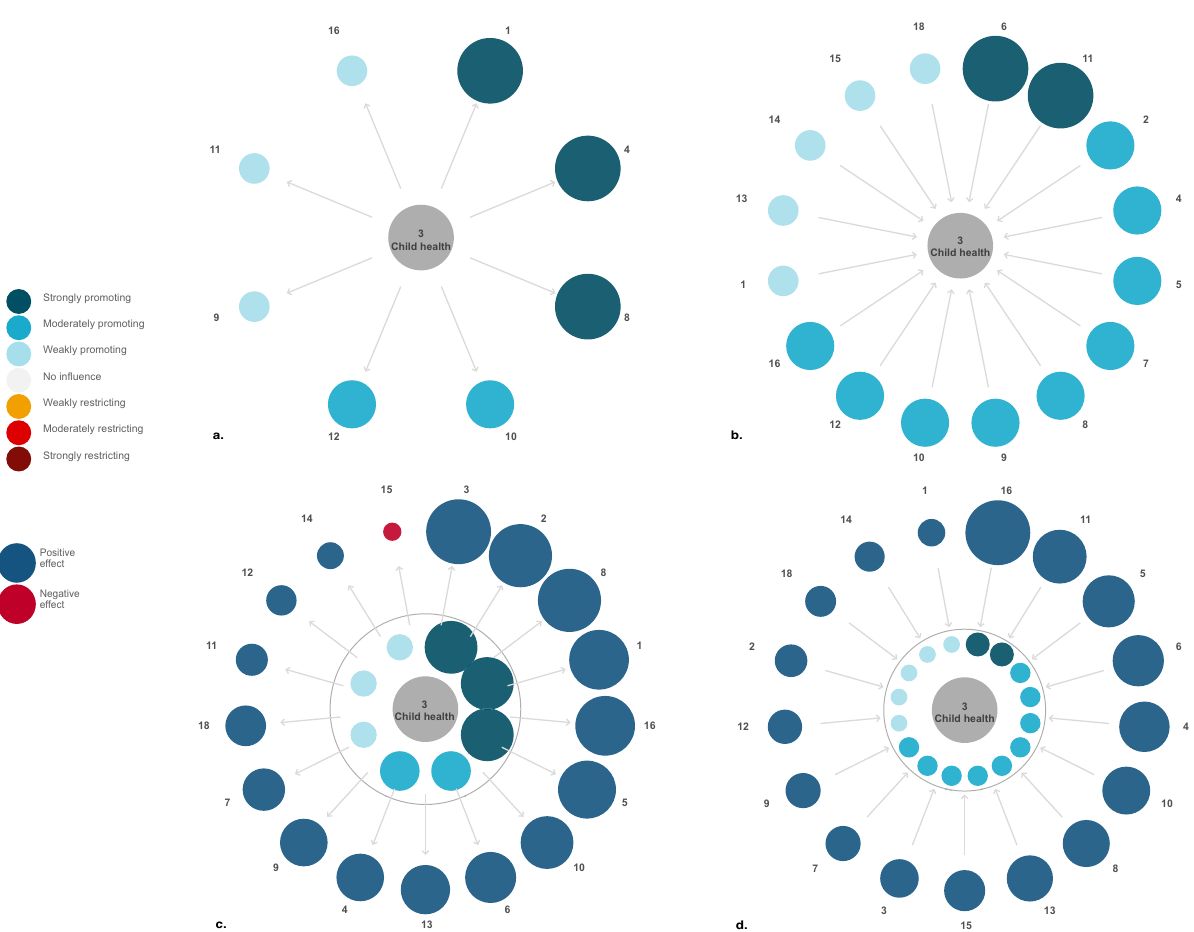
Fig. 3 The Cambodia Sustainable Development Goals from the perspective of child health. a , b : ( a ) Illustrate the fi rst-order in fl uence of child health on the CSDGs and ( b ) vice versa. c , d : ( c ) Illustrate the second-order in fl uence of child health on the CSDGs and ( d ) vice versa. Color according to scale. Cambodia Sustainable Development Goals 1 no poverty, 2 zero hunger, 3 child health, 4 quality education, 5 gender equality, 6 clean water and sanitation, 7 affordable and clean energy, 8 decent work and economic growth, 9 industry, innovation and infrastructure, 10 reduced inequalities, 11 sustainable cities and communities, 12 responsible consumption and production, 13 climate change, 14 life below water, 15 life on land, 16 peace, justice and strong institutions, and 18 mine/ERW